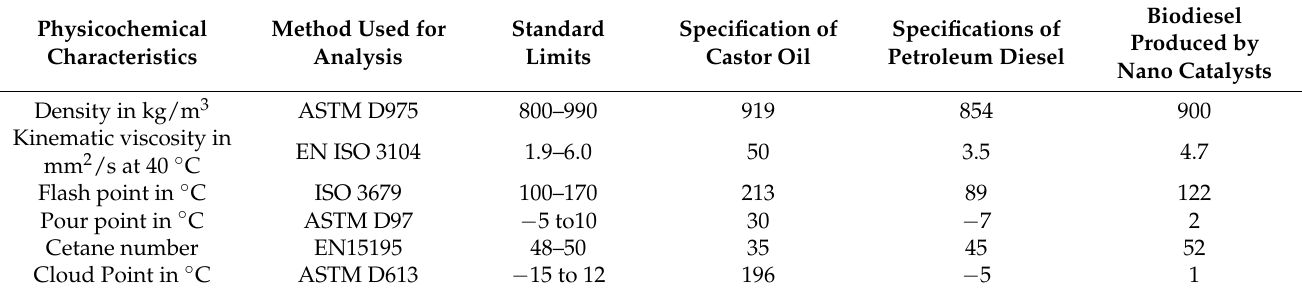
Table 1. Physicochemical properties of biodiesel produced from castor